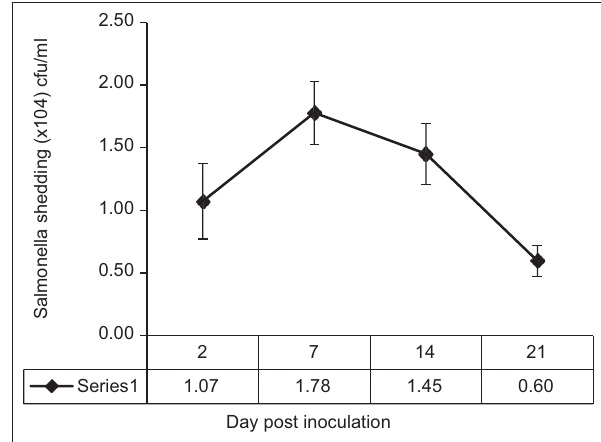
Figure-1: Fecal samples were collected from pigs orally infected with 1 × 10 9 colony-forming unit (CFU) of Salmonella Typhimurium over time, measured by the CFU methods. Significant differences between day post salmonella infection (analysis of variance, error bars represent standard error of the mean p < 0.05).